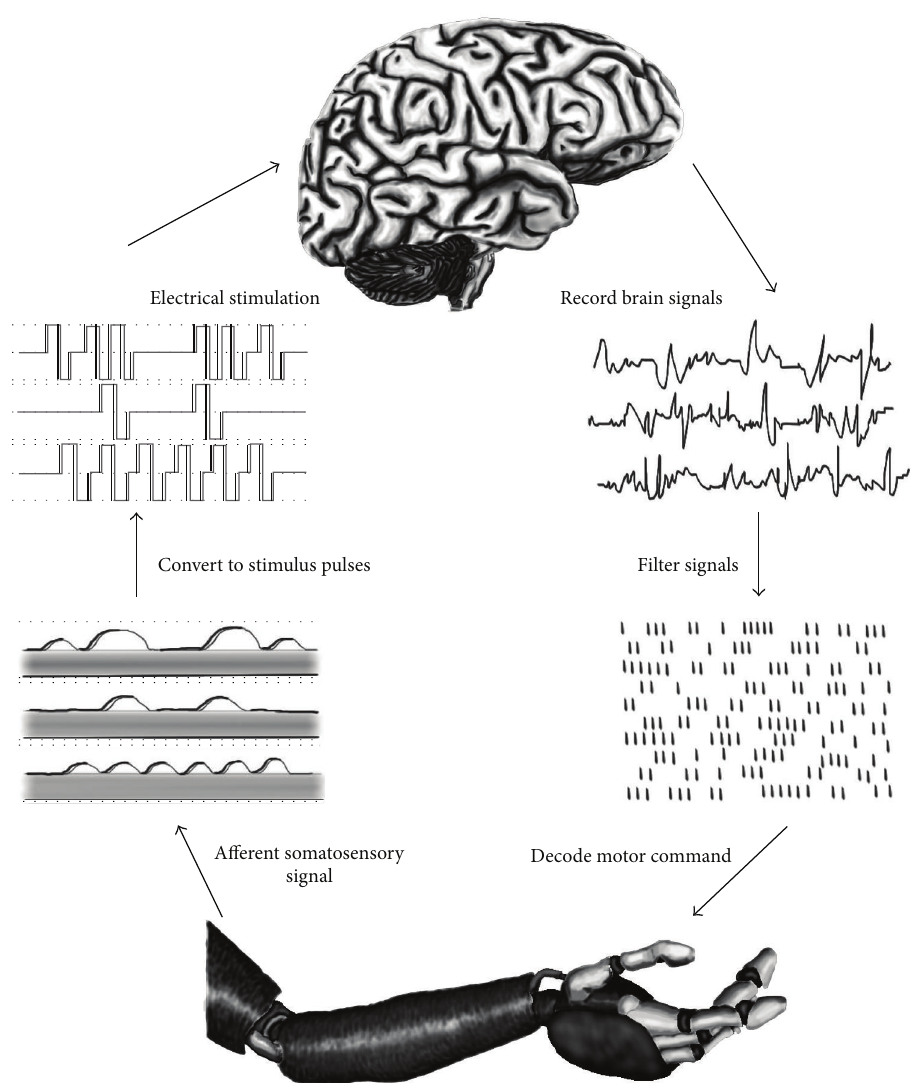
Figure 1: Working of neural prosthetics using a brain-machine interface. Afferent somatosensory signal is taken from the prosthetic device and is fed into the brain, from where the motor signal is sent back to the prosthetic limb